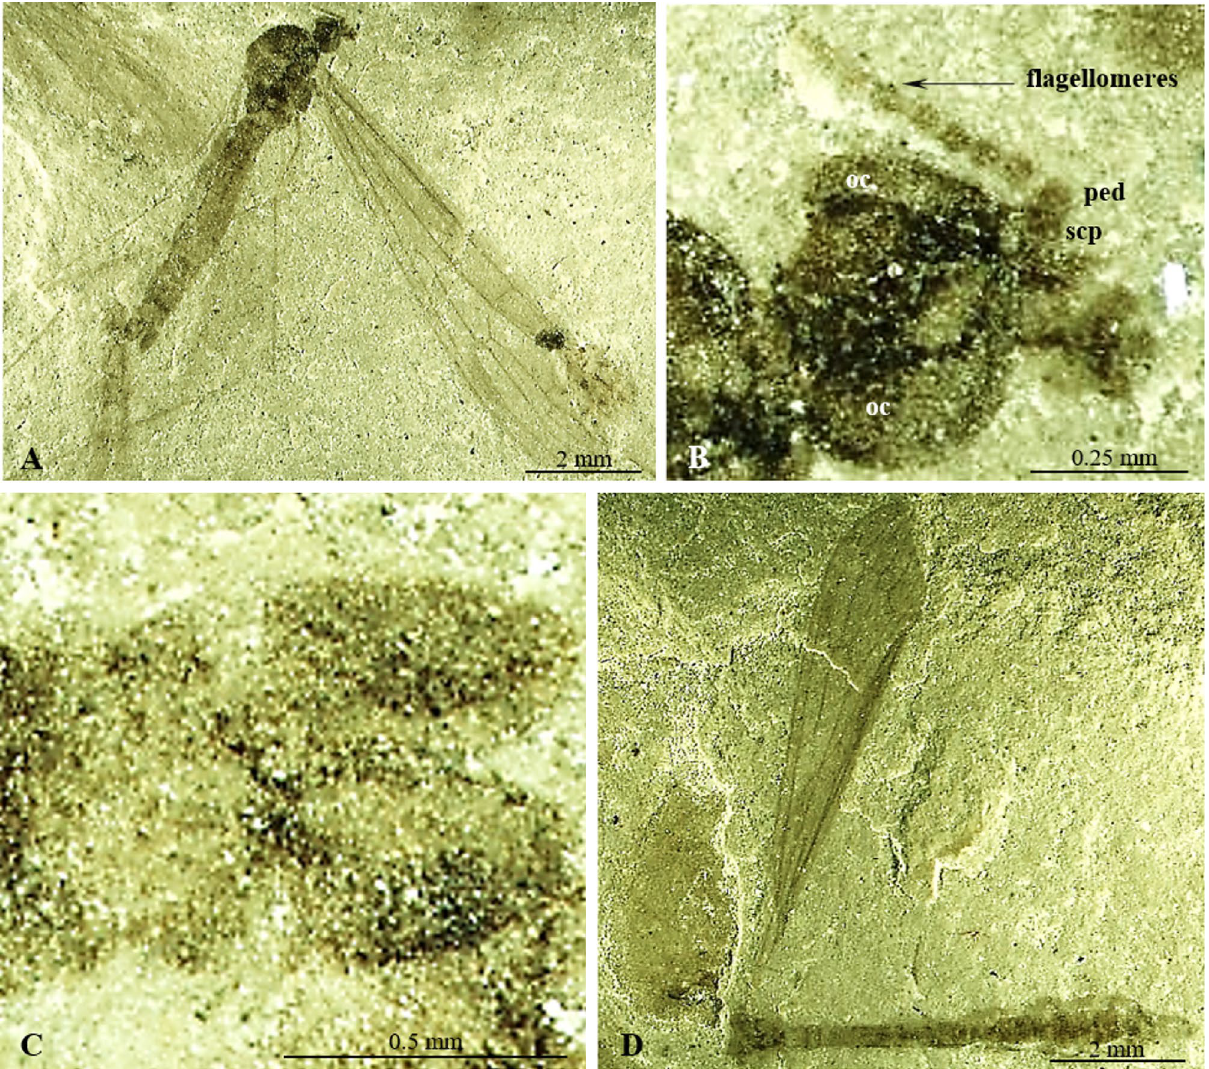
Figure 2. Cyttaromyia gelhausi sp. nov.: A.-C. No. MNHN.F.A71341 (18a, male) (holotype): ( A ) habitus, latero- ventral view; ( B ) head, ventral view; ( C ) hypopygium, ventral view; D. No. MNHN.F.A71341 (18c, female) (additional material), habitus, lateral view. oc, ocellus ; ped, pedicellus ; scp, scapus